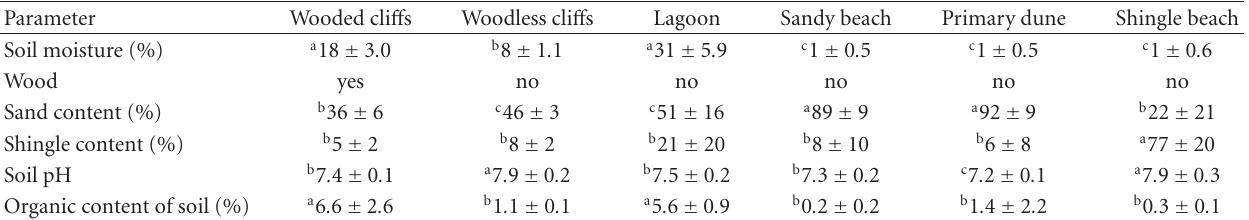
Table 2: Mean values of environmental parameters for the di ff erentiated staphylinid assemblages; di ff erent exponents indicate significant di ff erences by ANOVA and consecutive LSD